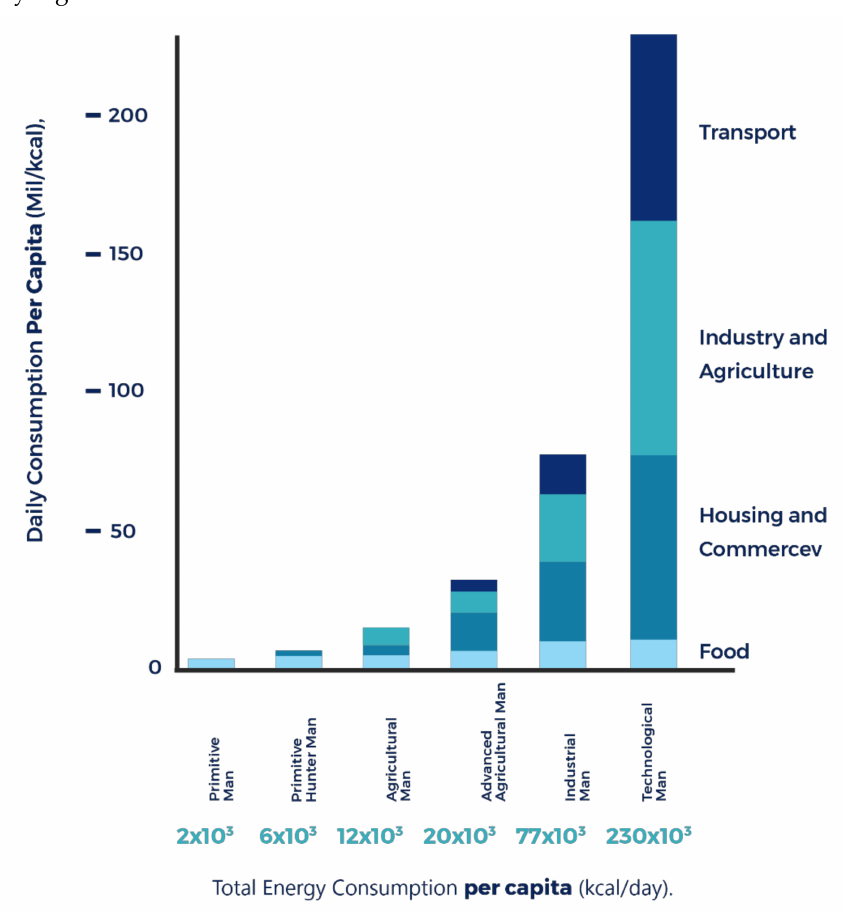
Figure 1. Evolution of daily energy consumption per capita in periods of human history. Source: Based on Goldemberg and Lucon (2012)